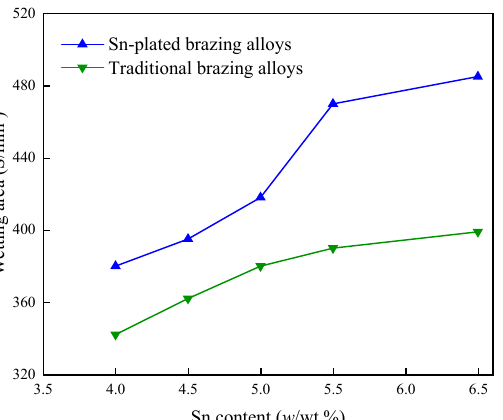
Figure 4. Variations in the wetting area of BAg34CuZnSn brazing filler metal with the increasing content of plated Sn [30].